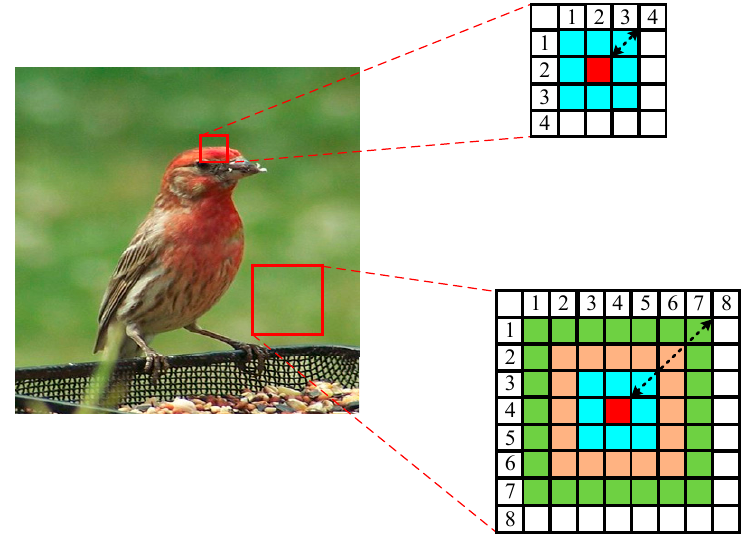
Figure 5. Wiener filter template adaptive selection.